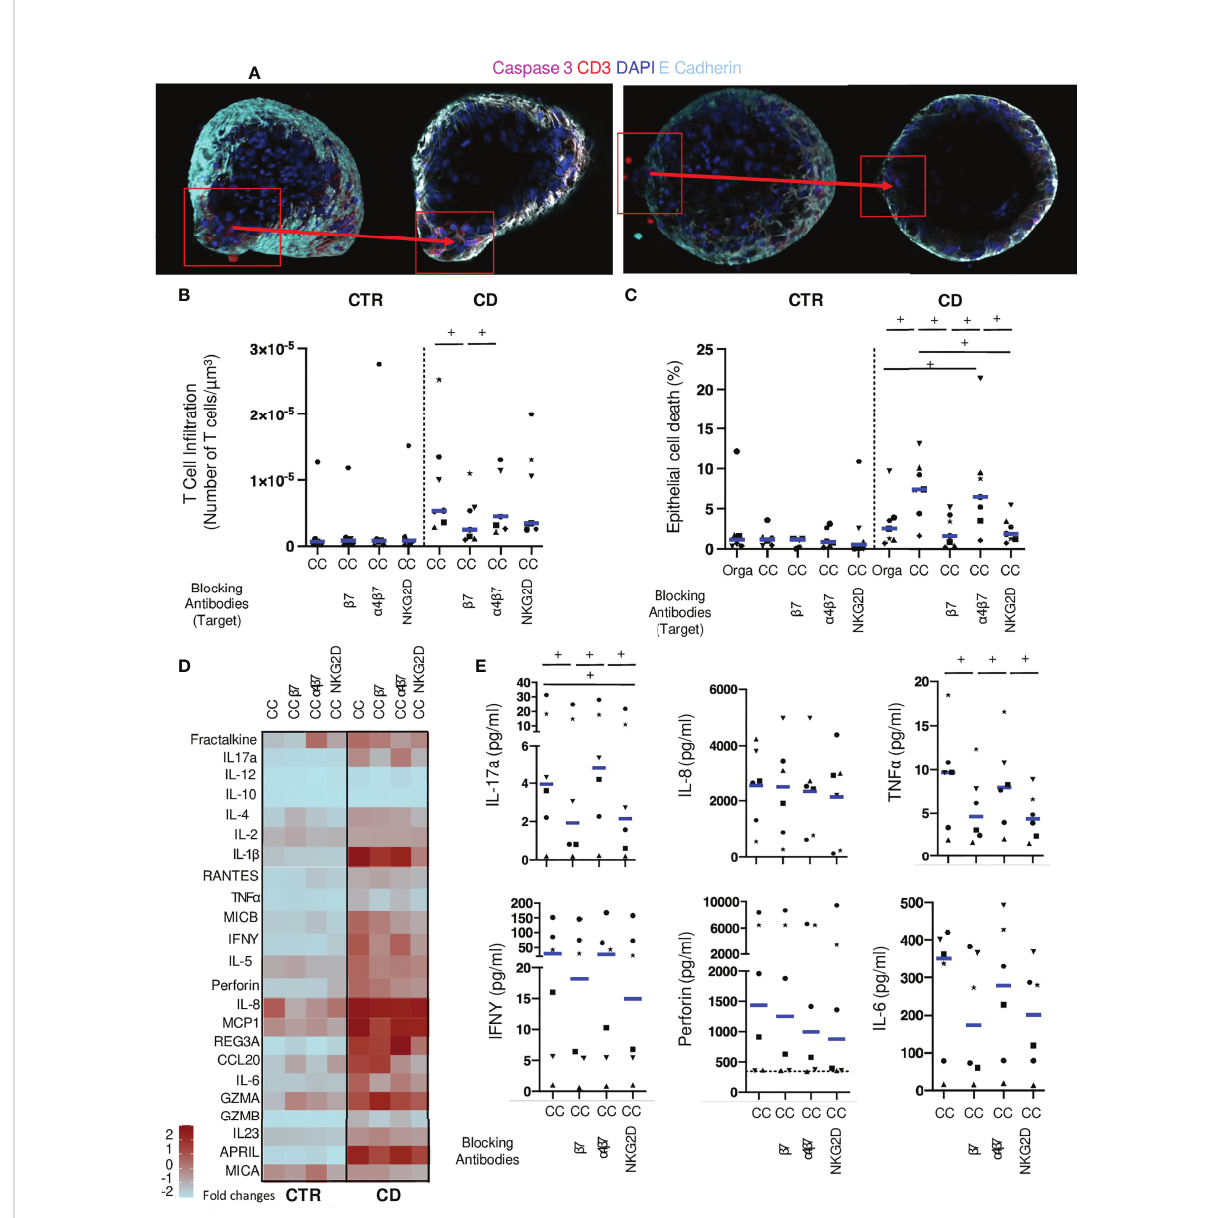
FIGURE 4 Monoclonal antibodies targeting lympho-epithelial interactions reduce epithelial cell death in co-cultures. (A) Organoid in coculture with mucosal T cells from CD patients without (left) or with anti-beta7 (right) in confocal microscopy (200X: Blue: DAPI; Light Blue: E-Cadherin, Red CD3, Pink: Caspase 3). (B) T cell in fi ltration in the organoids evaluated by the number of CD3 positive-cells in contact or in fi ltrating each organoid with LPS incubation. Each dot corresponds to the median of the values obtained for organoids of a given patient. Each shape of point corresponds to a given patient. CTR: n=6, CD: n=7. (C) Organoid epithelial cell death evaluated by Caspase 3 fl uorescence area over organoid volume in organoids alone or cocultures with LPS incubation. CTR: n=6, CD: n=7. (D) Cytokine detection matrix in the supernatant in LPS coculture conditions. Each square represents the median value of the results obtained for each well of a given condition in the distinct patients. The color of each square stands for the level expression (Form light blue: low expression to deep red: high expression). CTR: n=6, CD: n=6. (E) Absolute values of cytokine quanti fi cation of 6 analytes (IL-17a, IL-8, TNFalpha, IFNgamma, Perforin and IL-6) for CD patients. Each dot corresponds to the absolute value obtained for a given condition (with LPS). Each shape of point corresponds to a given patient. CC= Coculture, CD= Crohn ’ s Disease, CTR= Control, ML= Mucosal Lymphocytes, Orga= Organoid. +: p < 0.05 Wilcoxon paired